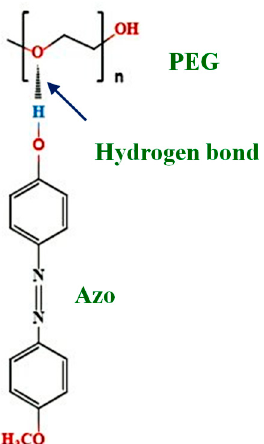
Figure 1. Chemical structures of polyethylene glycol (PEG) and 4-methoxy-4 ′ -hydroxyazobenzene (Azo).